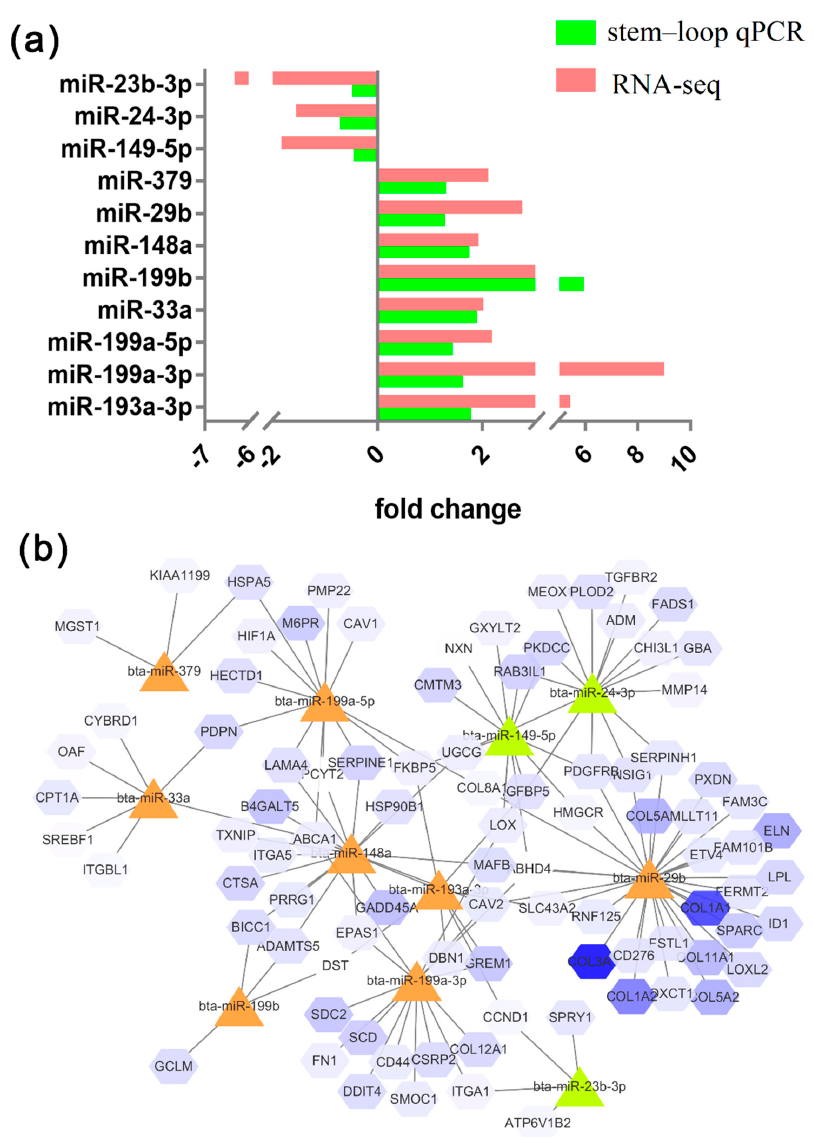
Figure 4. ( a ) Verification of sequencing results via stem–loop qPCR; ( b ) Network of differentially expressed miRNAs and their target genes.